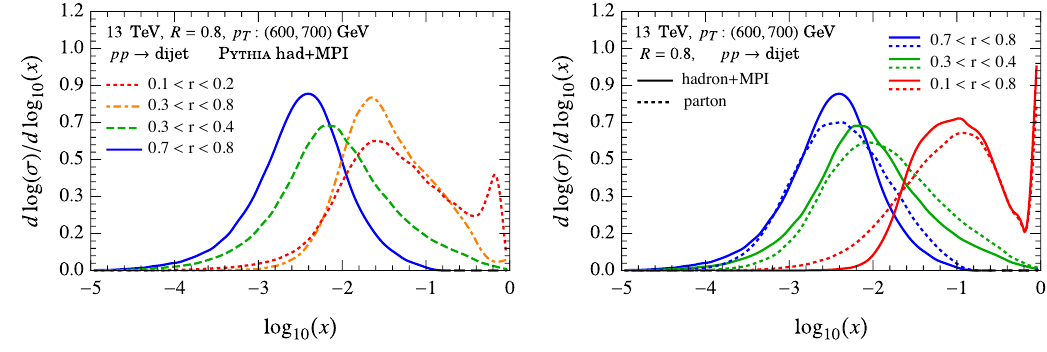
Figure 18 . Annulus Energy Fraction distributions of various ring regions. The left panel shows the results with hadronization and MPI e(cid:11)ects, while the right panel shows the partonic results as well as the hadronic results with multi-parton